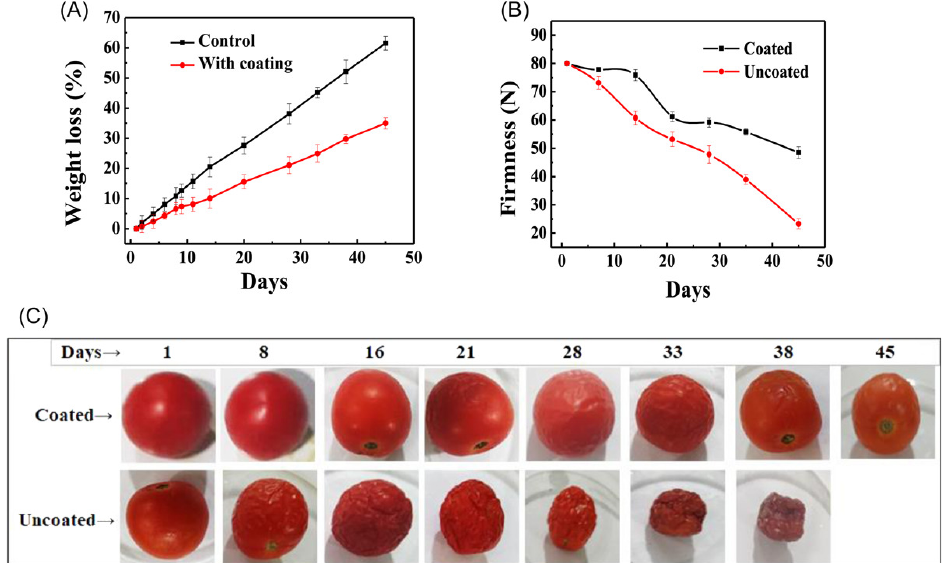
Figure 5. ( A ) Effect of sericin ‐ based edible coating on weight loss; and ( B ) effect of sericin ‐ based edible coating on the firmness for a period of 45 days of storage at 25 °C. ( C ) Photos of the